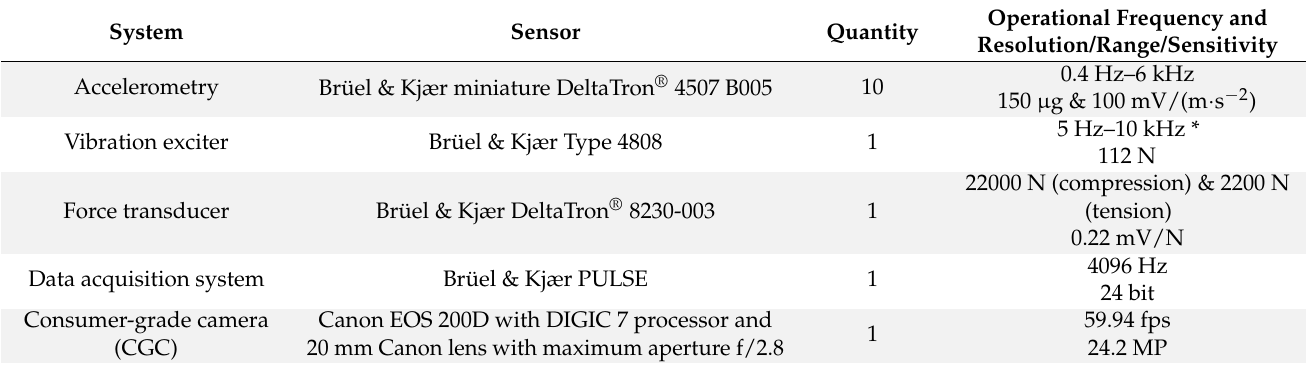
Table 2. Basic specification of the instrumentation systems used in this